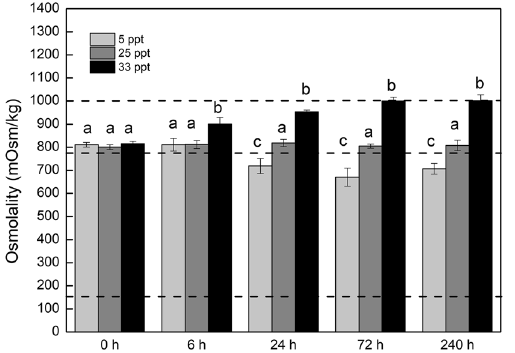
Figure 1. Hemolymph osmolality of crabs during different salinity acclimation. Dash lines represent osmolality of 5 ppt, 25 ppt and 33 ppt seawater (from bottom up). Significant differences are indicated by letters ( p < 0.05, one-way ANOVA followed by Dunnett’s multiple